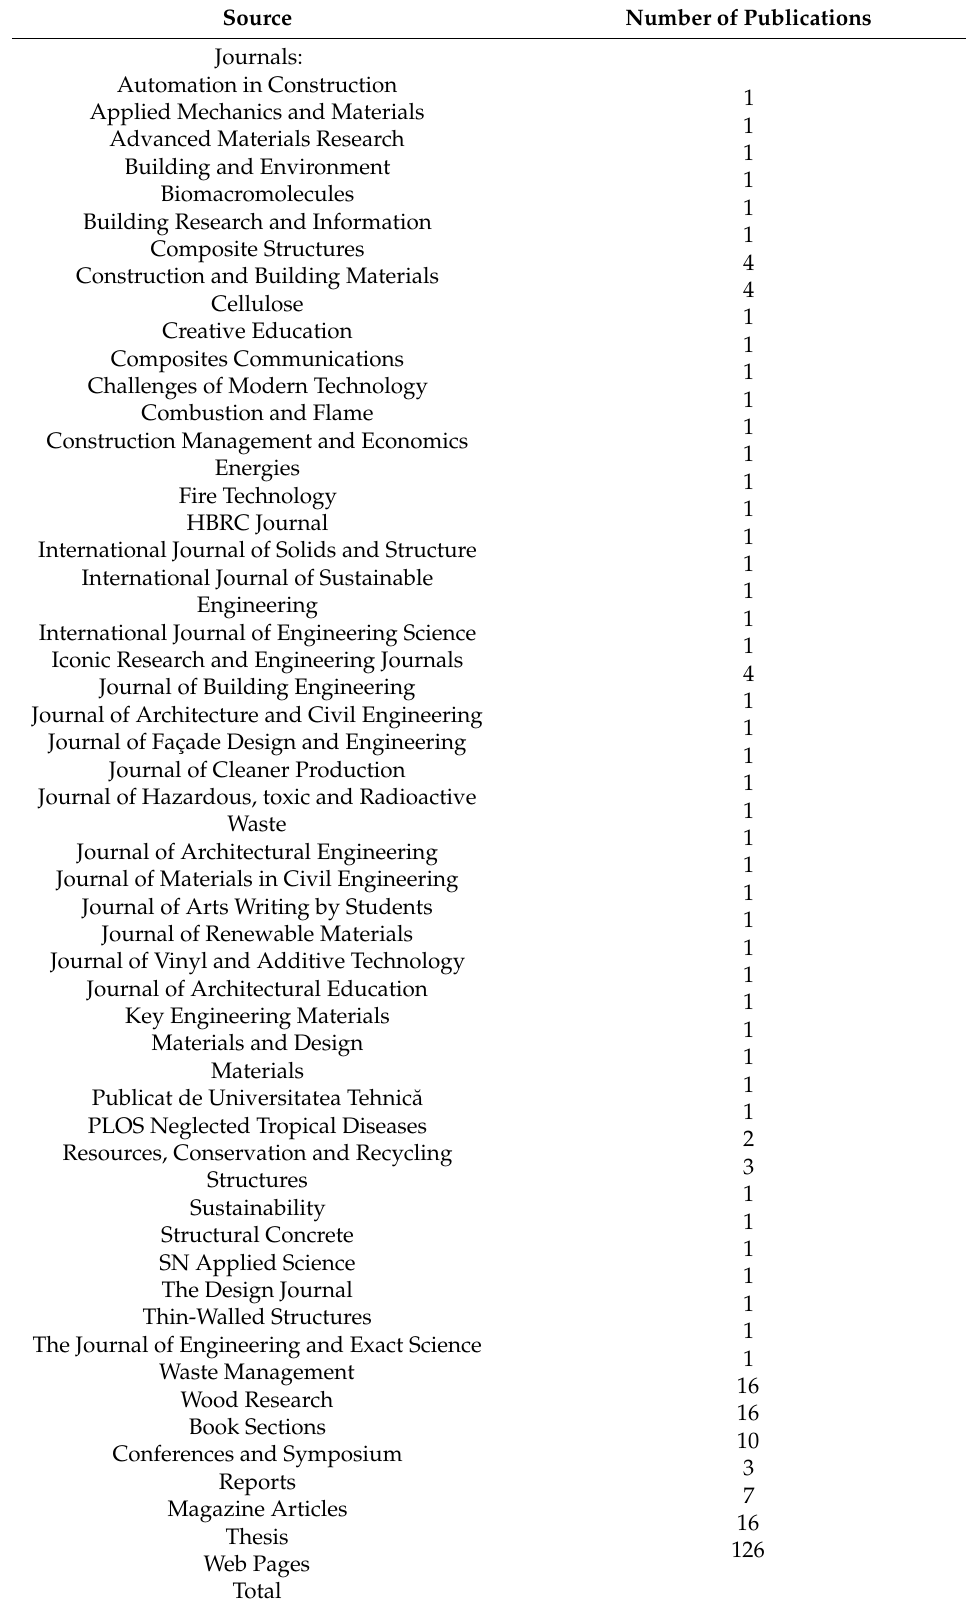
Table 1. Sources of reviewed